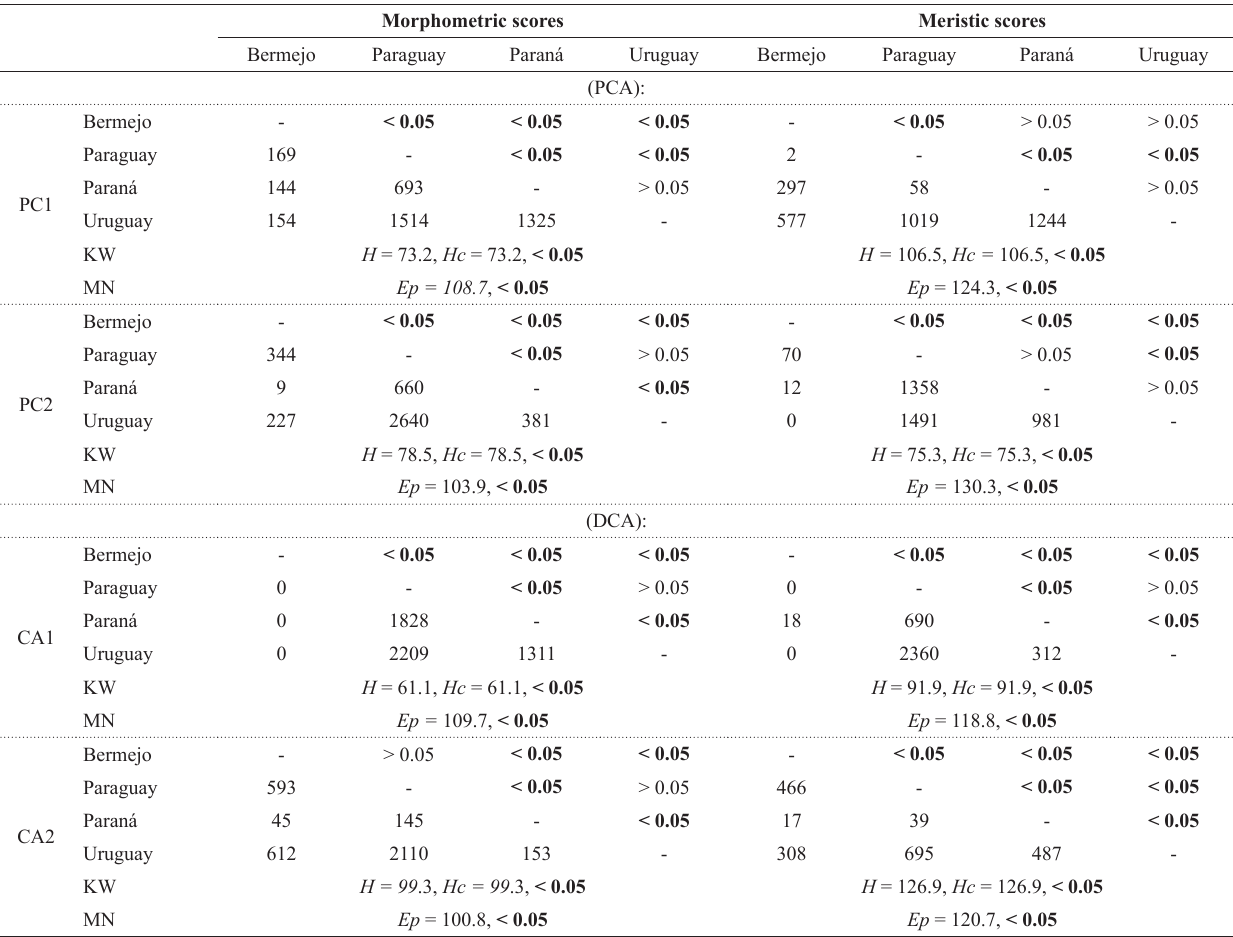
Tab. 5. Results of Kruskall-Wallis (KW) tests and Mann-whitney ( U ) pairwise comparisons (based on the Bonferroni- corrected p values ) of the resultant shape and meristic scores of principal component analysis (PCA) and discriminant canonical analysis (DCA). U values: below diagonal; multivariate normality: MN; p values are expressed as < 0.05 or > 0.05 (significant results in